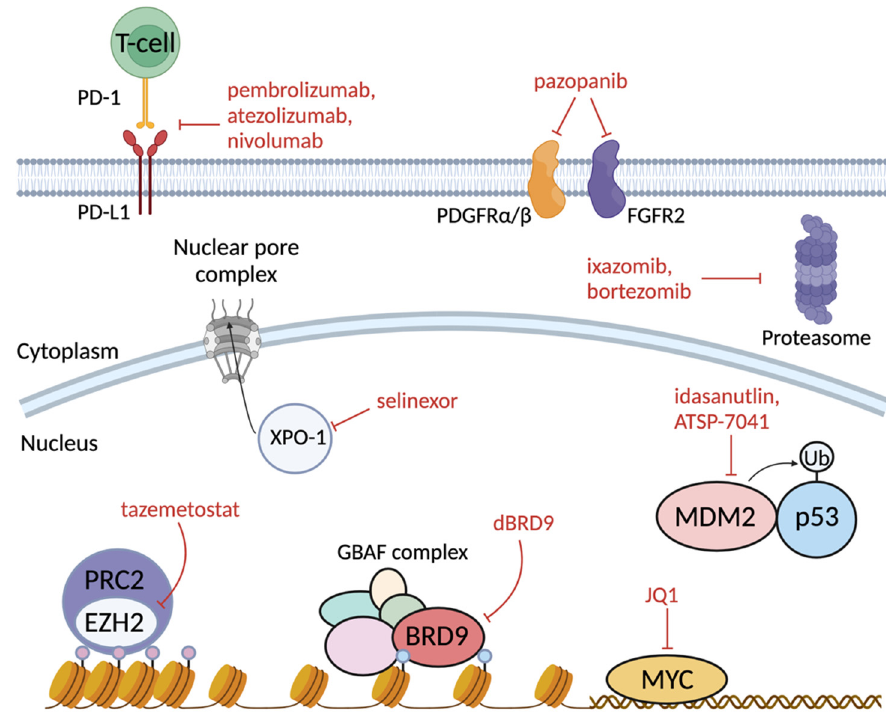
Figure 4. Therapeutic vulnerabilities discovered in SMARCB1-deficient cancers.